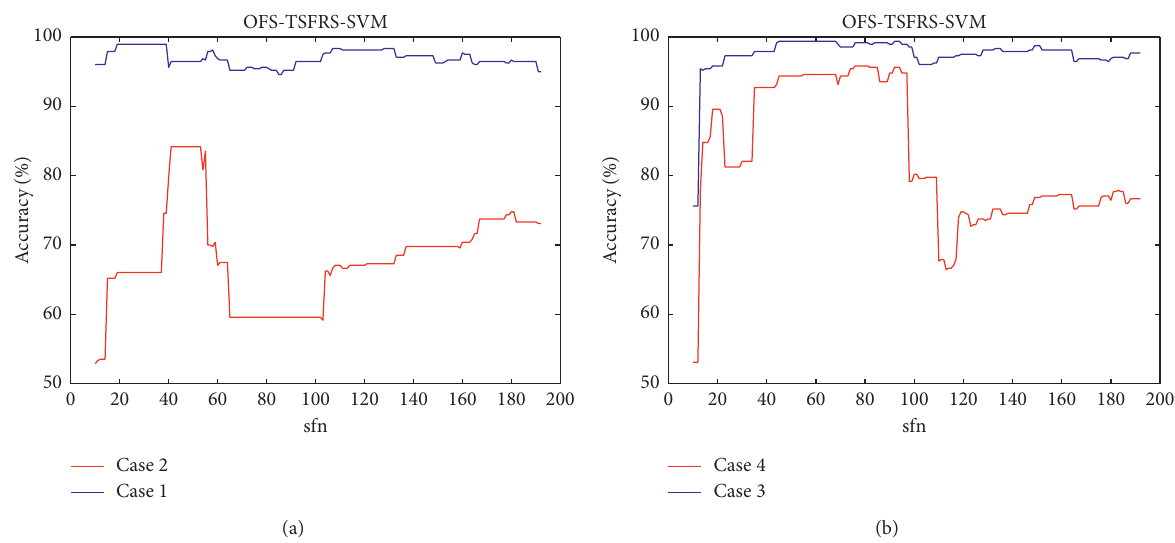
Figure 7: The curve representation of diagnosis results of OFS-TSFRS-SVM using WPT with different